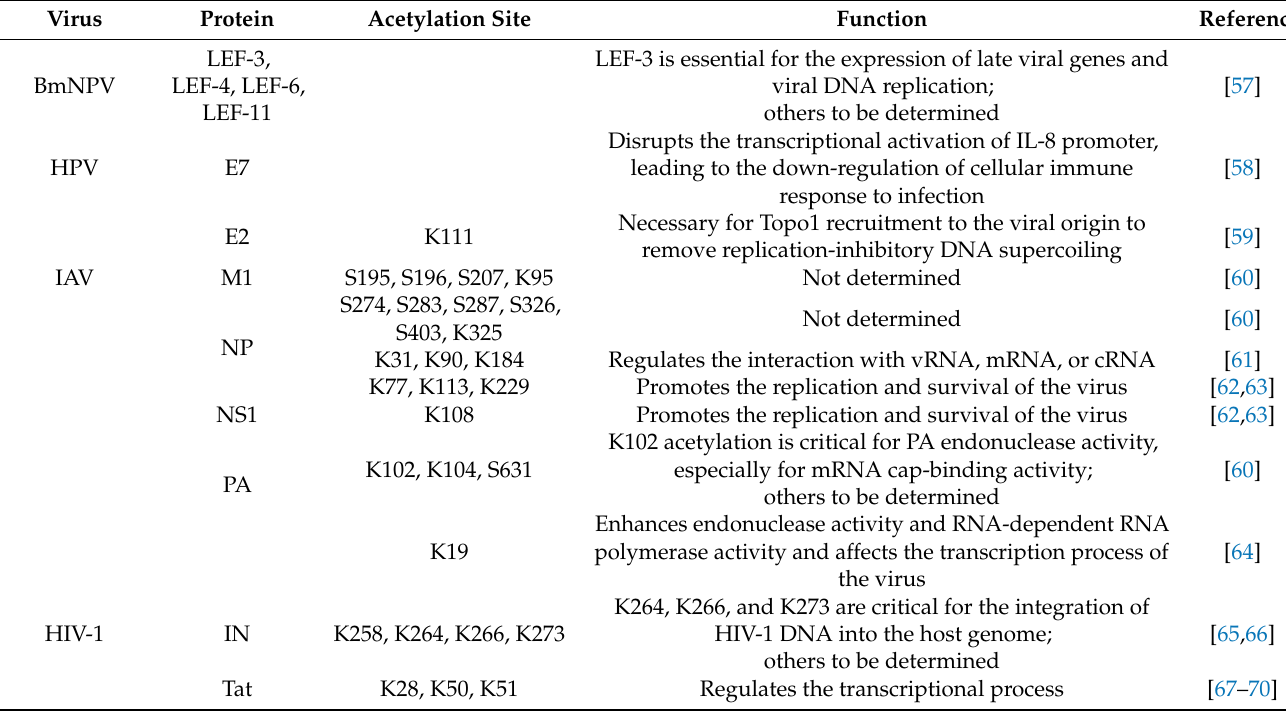
Table 3. Acetylation of viral proteins during viral